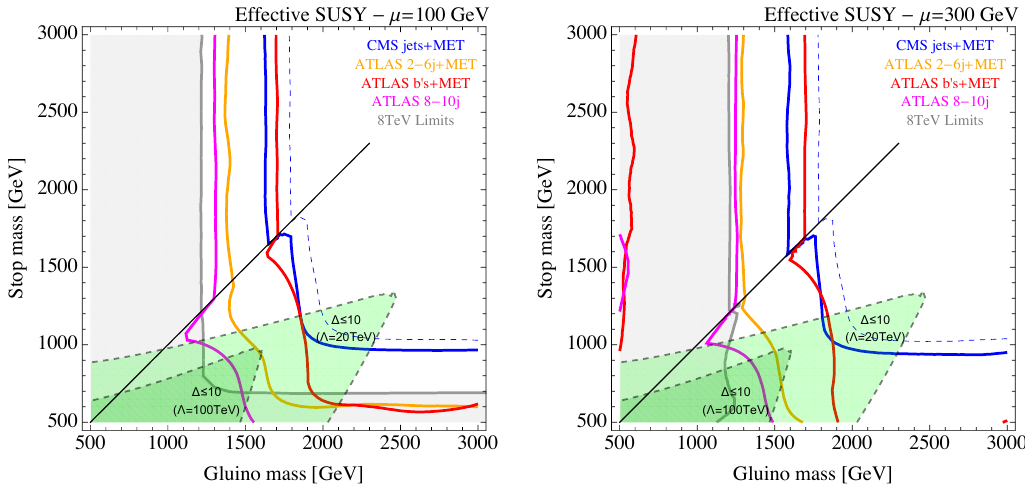
Figure 3 . Limits on the E(cid:11)ective SUSY model with (cid:22) = 100 GeV (left) and 300 GeV (right) as a function of the gluino and the stops and left-handed sbottom masses. The masses of the (cid:12)rst and second generation squarks are set to 5 TeV. All other conventions are as in (cid:12)gure 2. 4.2 E(cid:11)ective